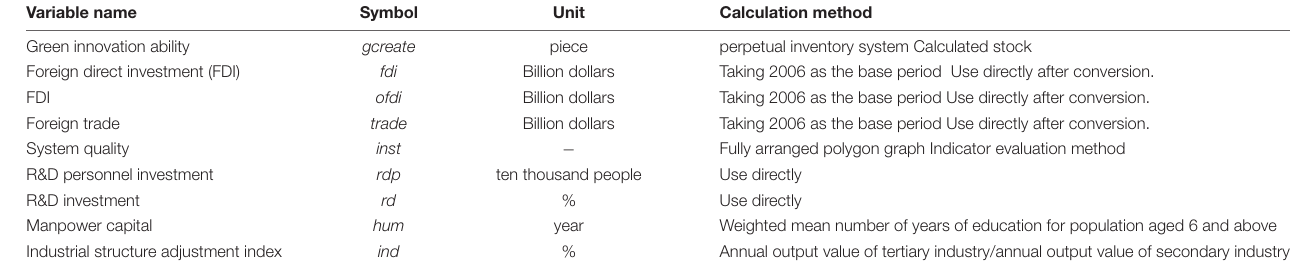
TABLE 3 | Variable description and statistical description.